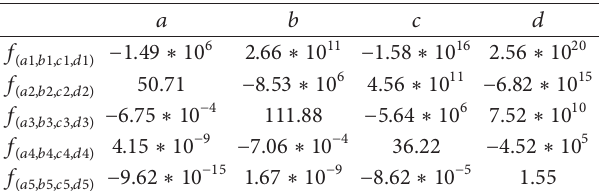
Figure 7: Efficiency model in polynomial form at stationary engine conditions (turbo speeds: 76130 rpm and 49600 rpm). Table 2: Coefficient values of function 𝑓 (𝑎,𝑏,𝑐,𝑑)